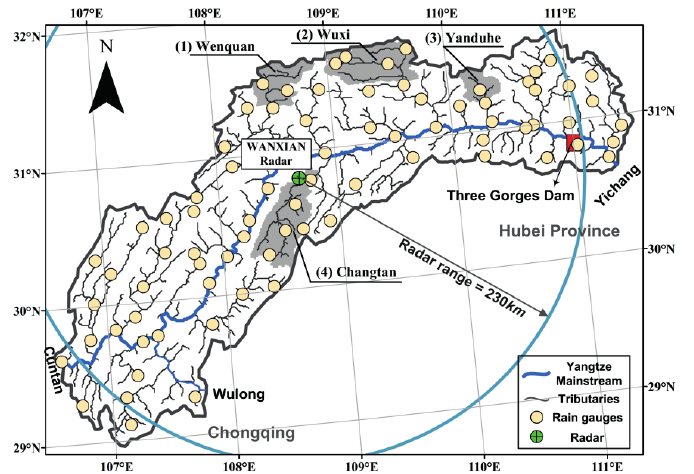
Fig. 1 Locations of raingauges and WANXIAN radar in the Three Gorges